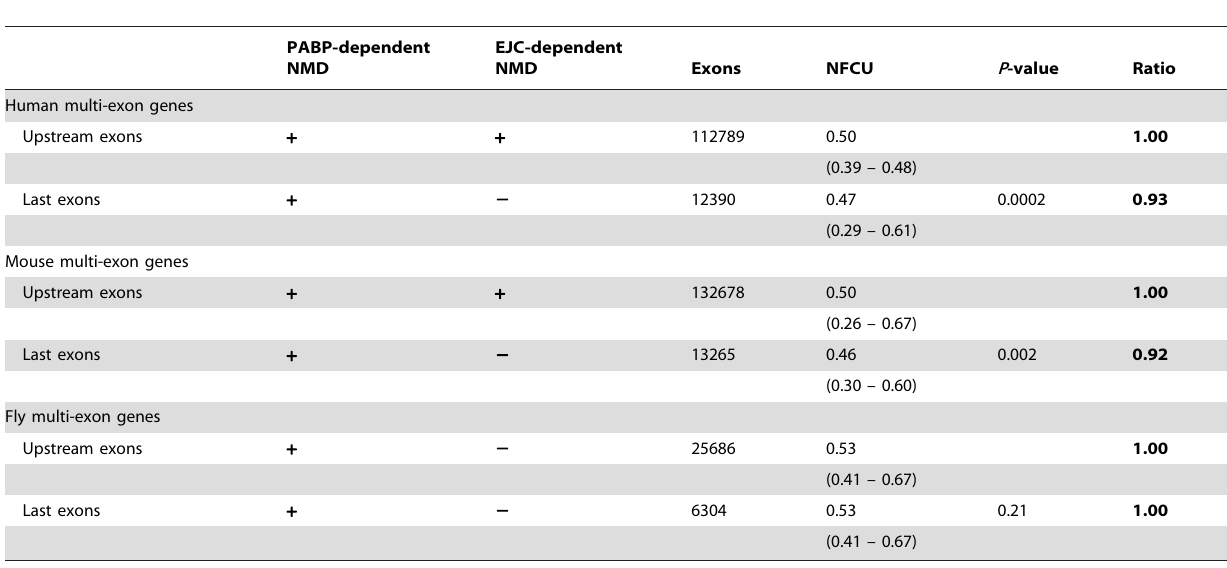
Table 4. Normalized fragile codon usage (NFCU) of last exons and upstream exons of multi-exon genes in the human, mouse, and fly